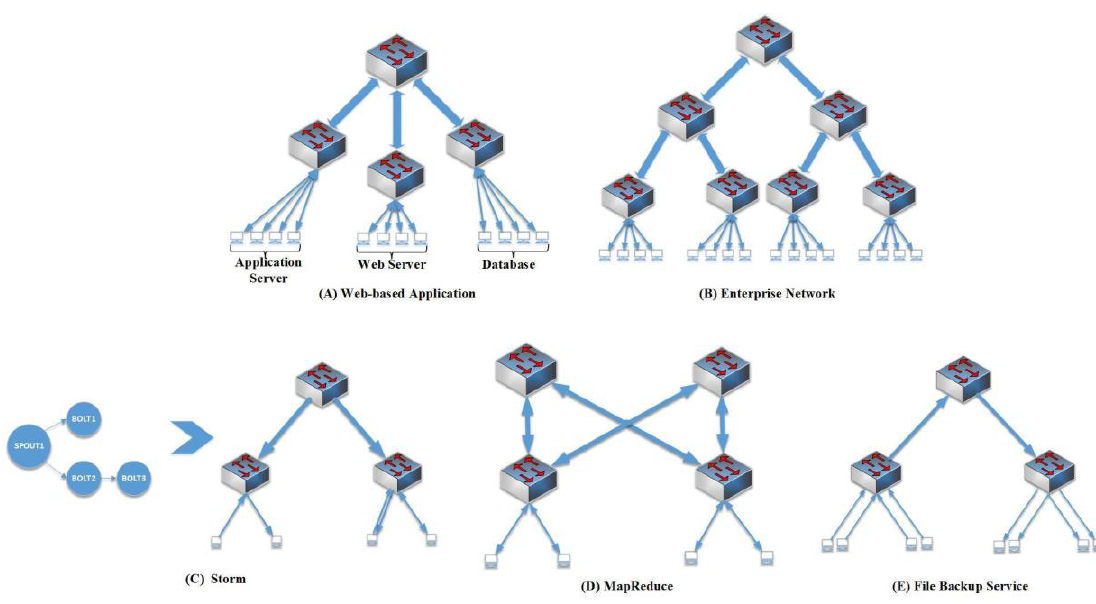
Figure 9. Application types in cloud datacenter.